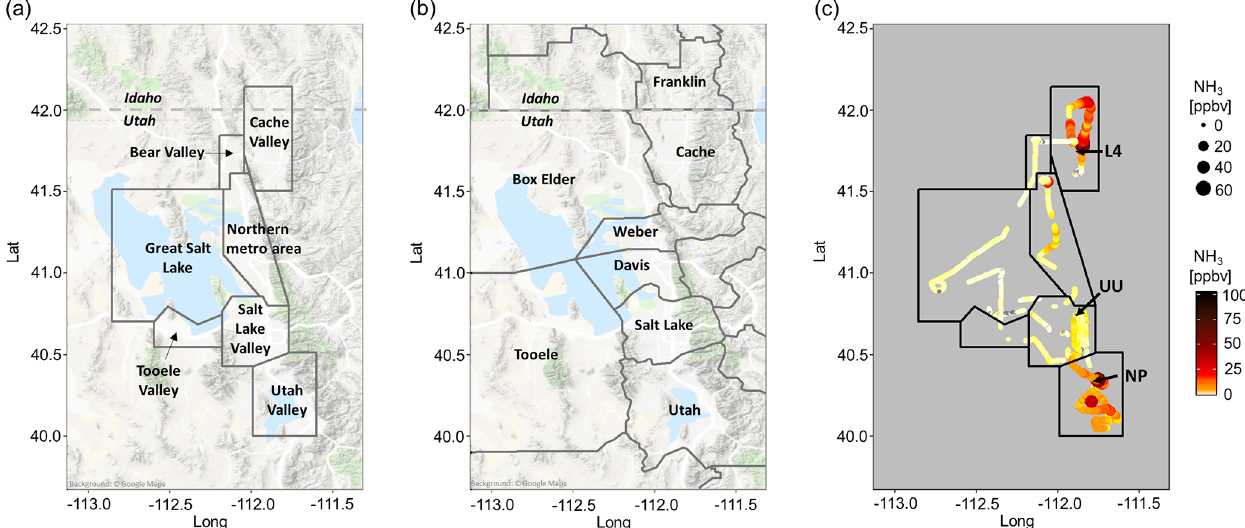
Figure 1. Overview of the study area: (a) outlines of sub-regions used for the analysis of Twin Otter measurements, (b) borders of counties which are part of the study area, and (c) typical NH 3 mixing ratios measured from the Twin Otter combined from a northern and southern flight leg flight on 17 and 18 January, respectively. Arrows in (c) indicate the location of ground site measurements used for this study in northern Provo (NP), at the University of Utah (UU) and in Logan (L4). Borders of the sub-regions are shown in (c) for reference. Salt Lake City, the most populated area, is situated in the northeastern part of Salt Lake